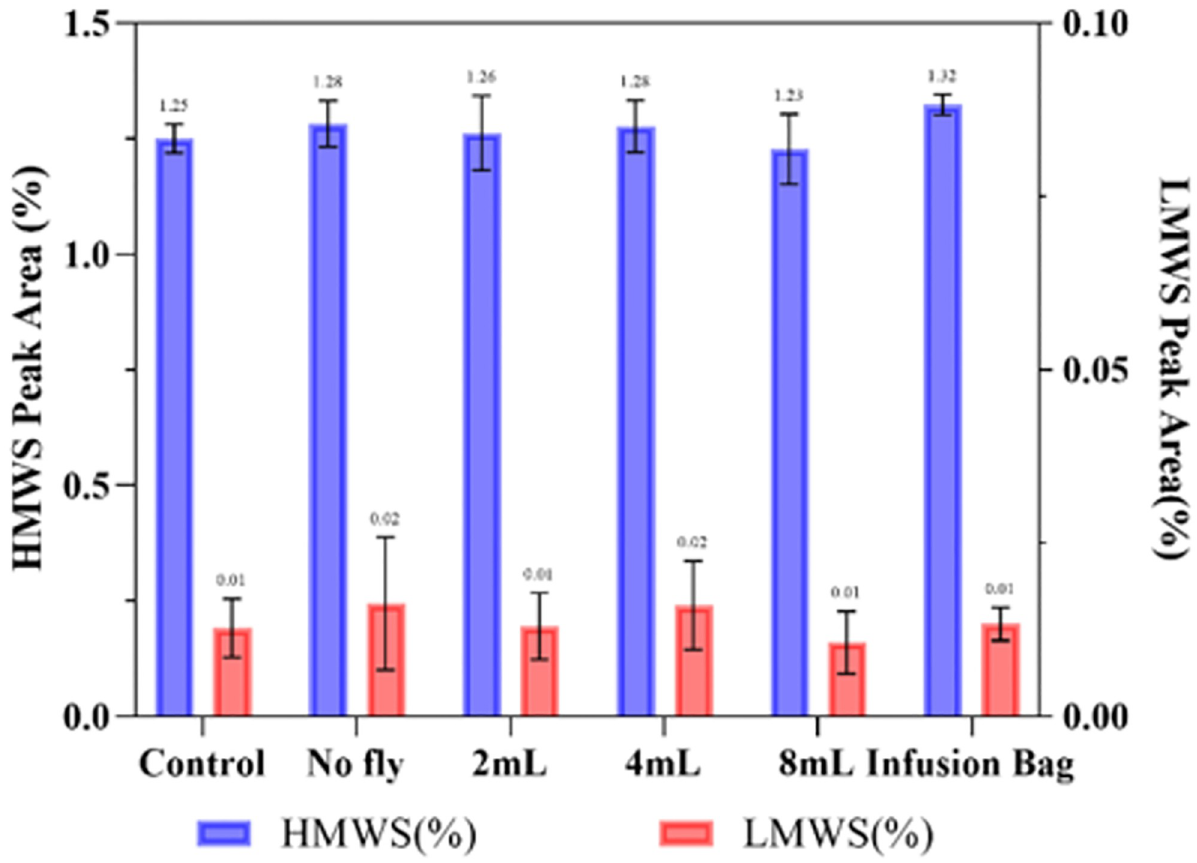
Fig 10. SE-HPLC peak area (%) of Bevacizumab of aggregates (HMWS) and fragments (LMWS) in different storage conditions (trial 2). Data are shown as mean ± SD (n = 3).